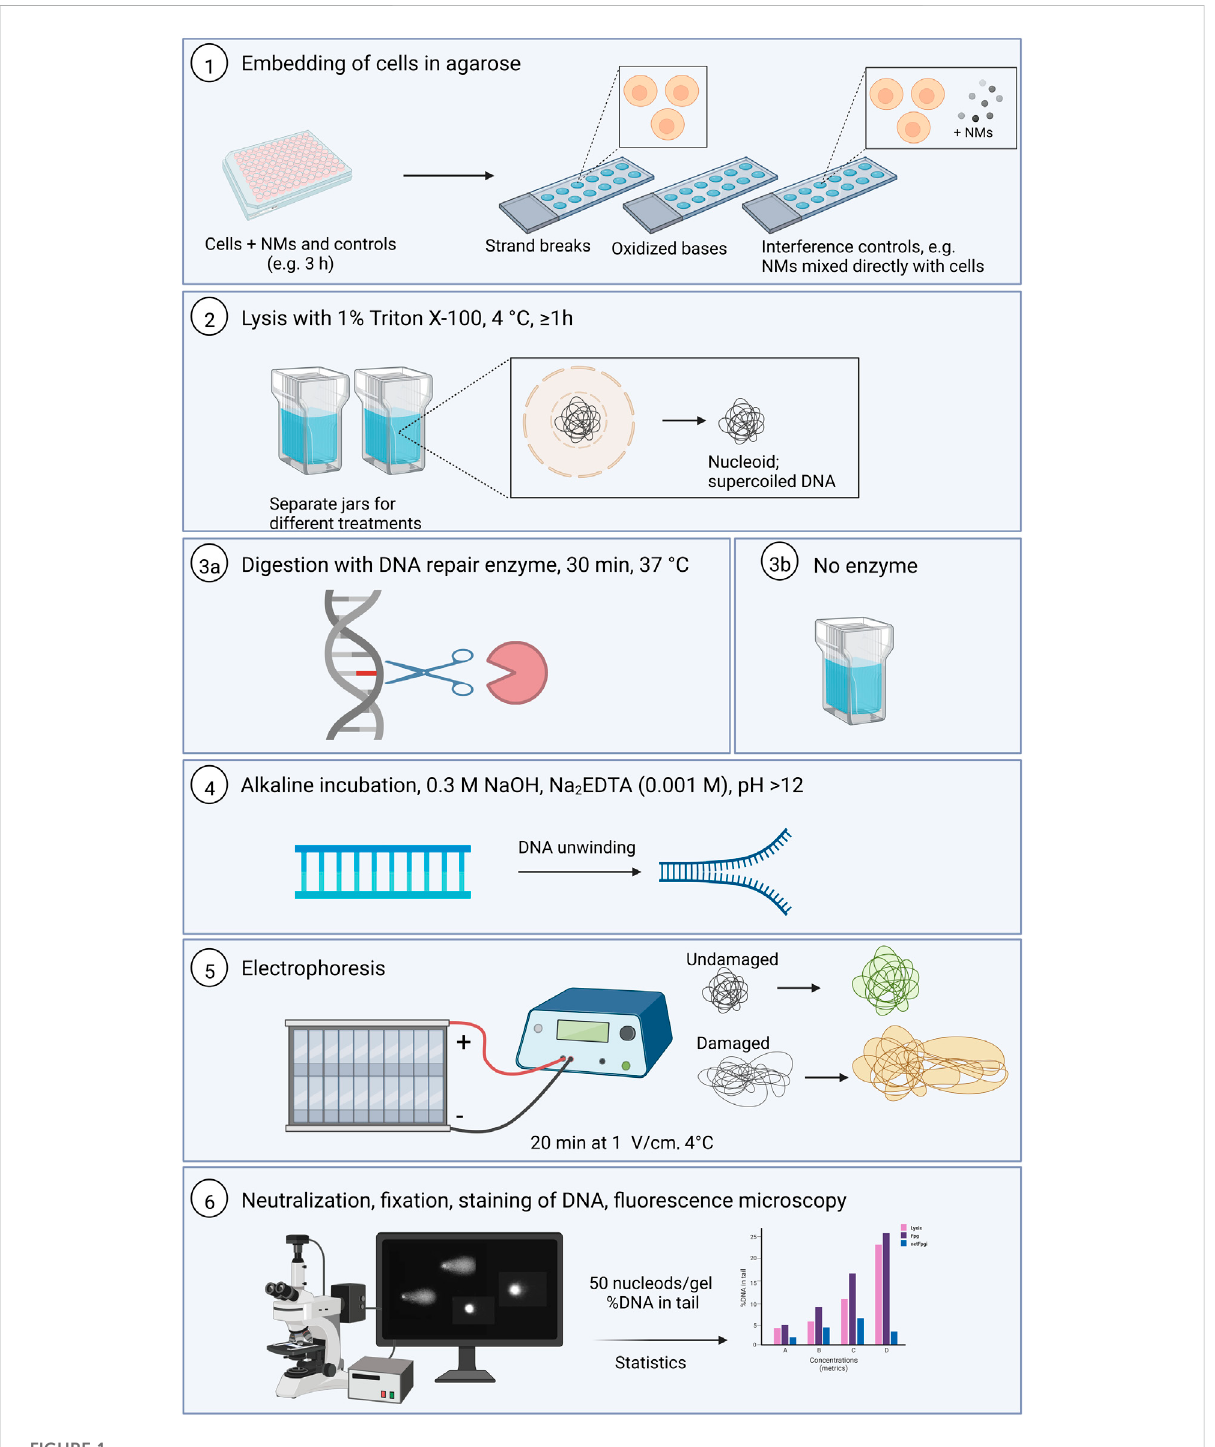
FIGURE 1 Summary ofthecomet assayprotocolforbothstandardandtheenzyme-modi fi edversion(Created withBiorender.com).1.Cellsareseededin correctdensityusing96wellformatandexposedtotheNMsandcontrolsandafterexposuretime,thecellsareembeddedwith0.8%LMPagaroseto make 12-gel format slides. 2. Lysis incubation at 4 ° C for at least 1 h 3a. the slide with samples to be incubated with DNA repair enzyme to reveal oxidative damage are incubated with the enzyme for 30 min at 37 ° C. 3b. The slides with samples for DNA strand breaks detection remain in the lysis solution. 4. All the slides are placed in the alkaline solution for DNA unwinding. 5. Electrophoresis is run for 20 min at 1V/cm. 6. At the end of the unwinding, all theslidesare washed bythe neutralization solution, fi xed and thenstainedbeforevisualization andscoring. 50nucleoids areanalyzed per sample or gel. %DNA in tail parameter is collected and statistical analyses performed. h, hours; d, days; LMP, low melting